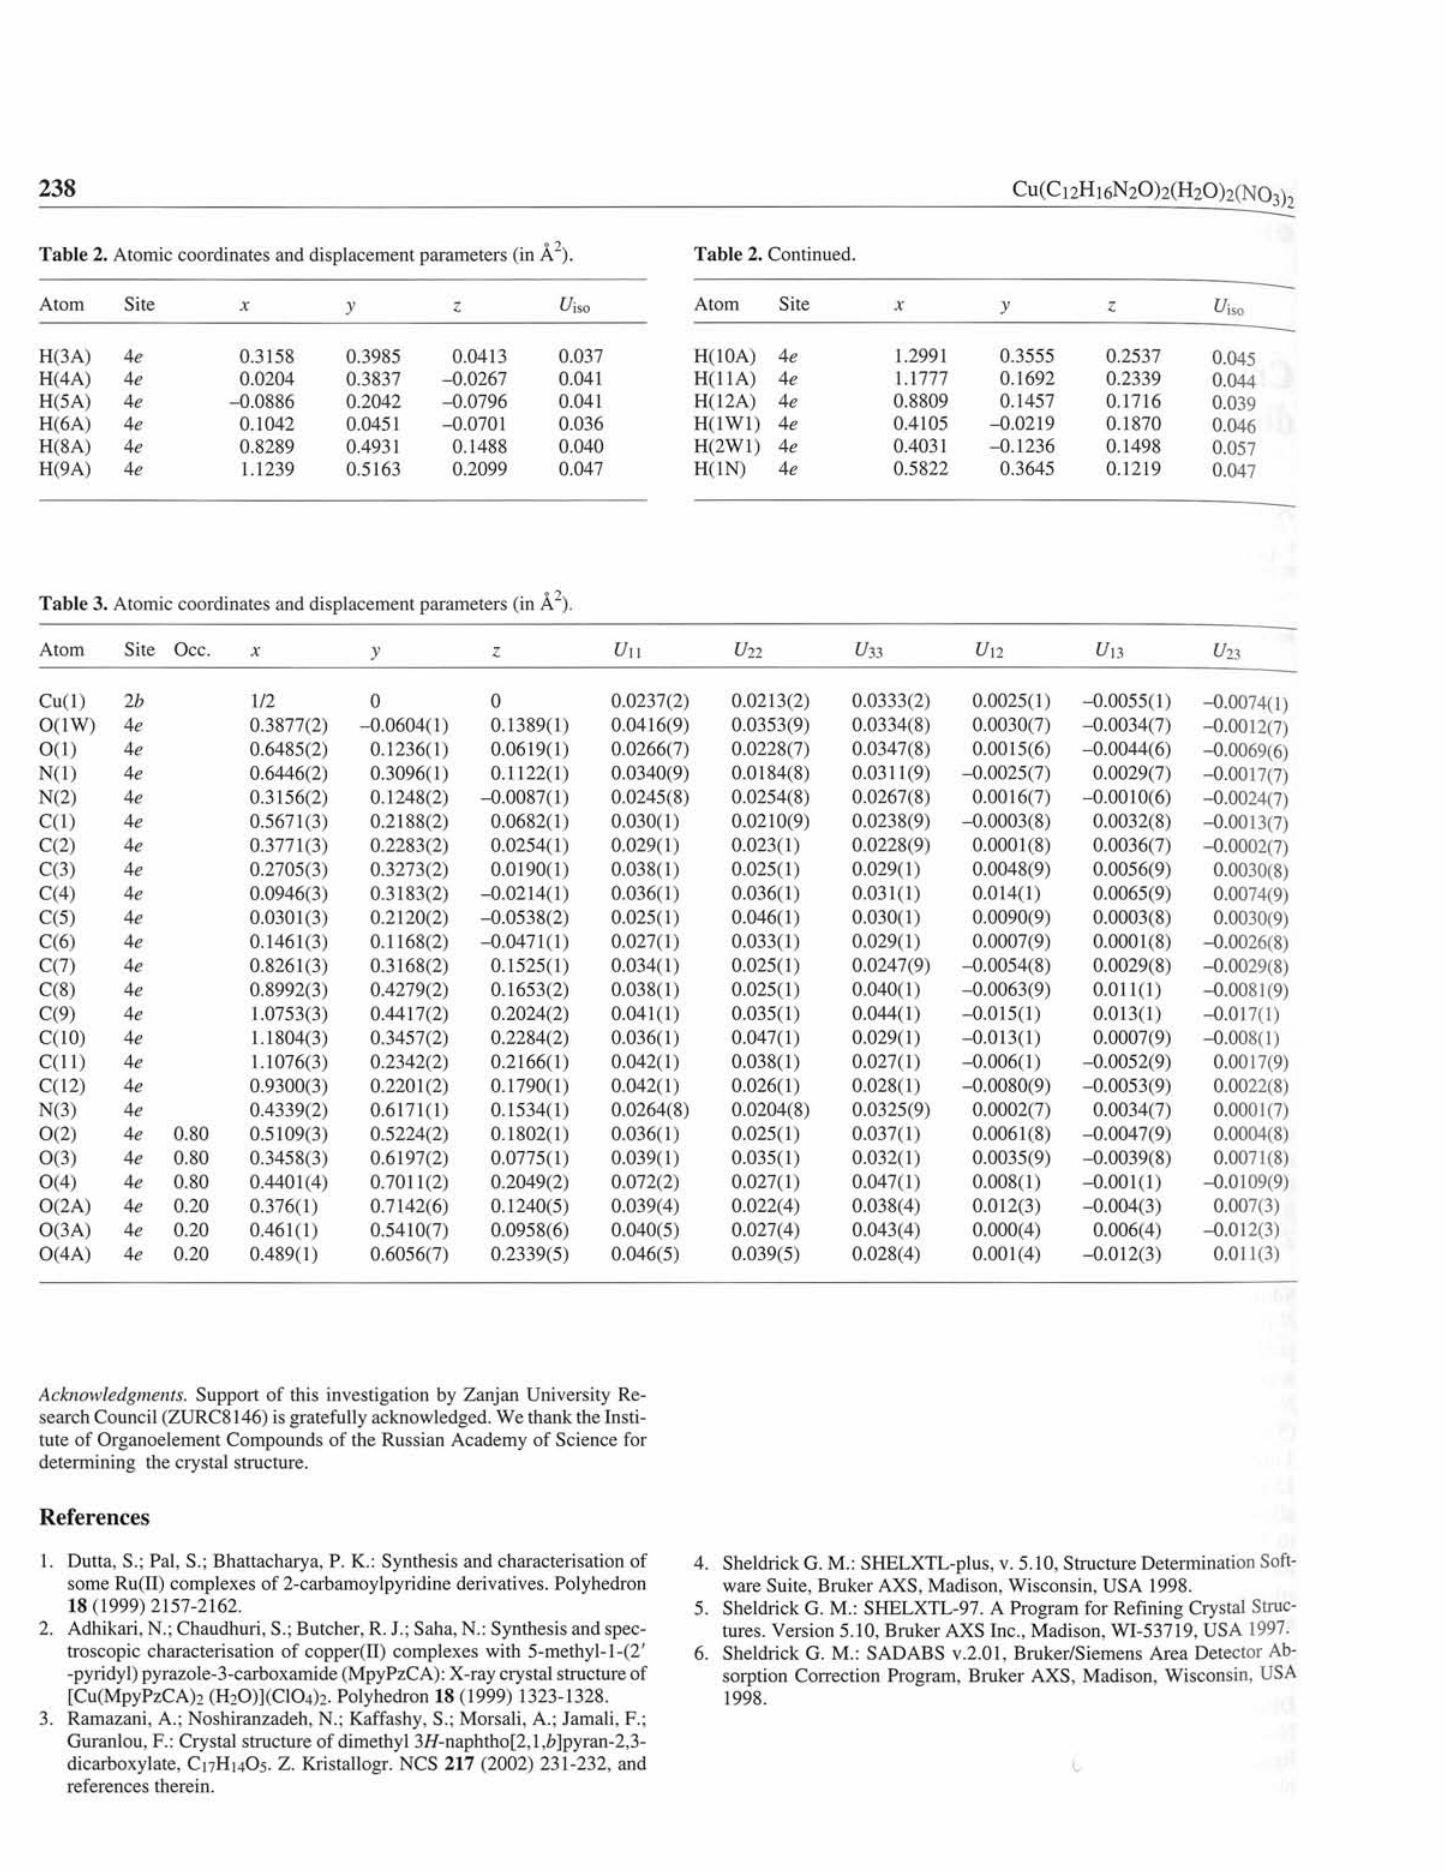
Table 3. Atomic coordinates and displacement parameters (in À 2